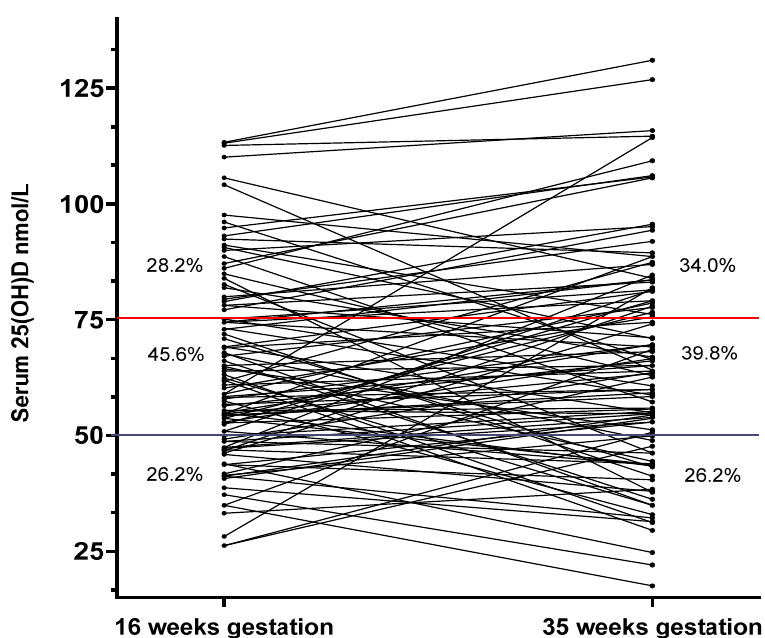
Figure 1. Serum 25(OH)D levels at 16 and 35 weeks gestation in pregnant women with asthma. Serum 25(OH)D at 16 and 35 weeks gestation in 103 pregnant women with asthma. Dots represent individual 25(OH)D values, with connecting lines demonstrating the within-person trajectory from 16 to 35 weeks gestation. Major horizontal lines at 75 and 50 nmol/L represent the cut-points for vitamin D ‘sufficiency’ and ‘deficiency’. The proportion of women who fell into the categories of ‘sufficient’, ‘insufficient’ and ‘deficient’ are presented on the graph at both 16 and 35 weeks gestation. 25(OH)D: 25-hydroxyvitamin D. Table 1. Demographics by maternal vitamin D status during pregnancy for women with